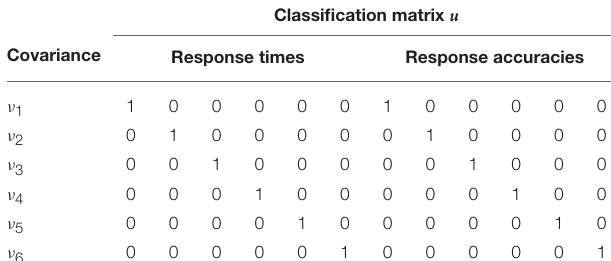
TABLE 2 | The additive covariance structure of the variable speed-accuracy trade-off model is an extension of the BCSM for speed and ability with item-specific cross-covariances between RTs and RAs.